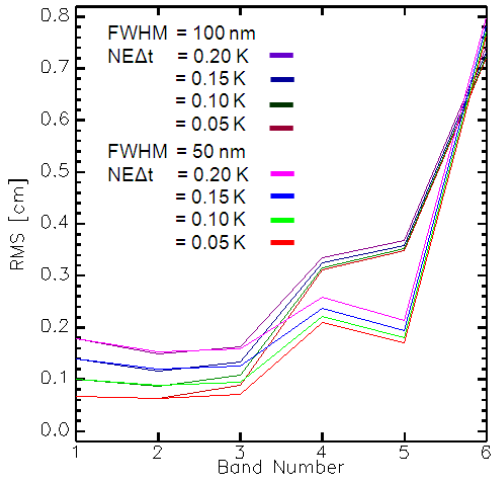
Figure 2. RMSE of CWV retrieval for four noise levels and seven bands (band 1 = 7.15 µm, band 2 = 7.27µm, band 3 = 7.33 µm, band 4 = 7.46 µm, band 5 = 7.59 µm, band 6 = 7.66 µm).